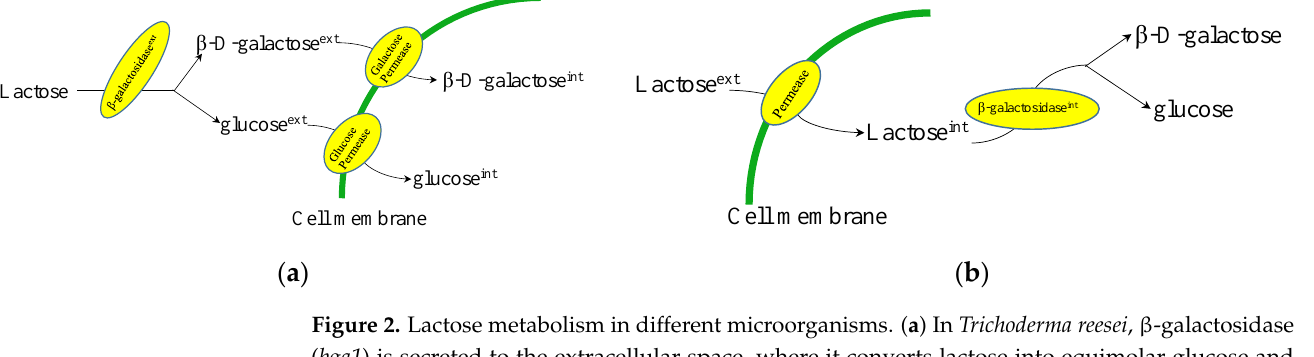
Figure 2. Lactose metabolism in different microorganisms. ( a ) In Trichoderma reesei , β-galactosidase ( bga1 ) is secreted to the extracellular space, where it converts lactose into equimolar glucose and galactose monosaccharides, which are then imported into the cytoplasm. ( b ) In Aspergillus nidulans and Kluyveromyces spp., lactose is first transported into the intracellular space by lactose permease ( LAC12 ) where it is catalyzed into galactose and glucose by cytosolic β-galactosidase ( LAC4 ). T. reesei uses the former pathway for lactose uptake, although the extracellular β -galactosidase (encoded by bga1 gene) is a critical factor for lactose-induced cellulase production [62,63]. A. nidulans and K. lactis , a model microorganism of Kluyveromyces yeast, both utilize lactose through the latter strategy by lactose permease (encoded by LAC12 gene)-mediated transport of the disaccharide into the intracellular compartment and subsequent hydrolysis by β -galactosidase (encoded by the LAC4 gene) into glucose and β - D -galactose. This review does not discuss the catabolism of D -glucose in detail since several current reviews already address this topic. In most eukaryotes, α - D -galactose is converted by aldose 1-epimerase to the α -anomer before entering the Leloir path- way (Figure 3) [64,65], although filamentous fungi contain a second pathway, the oxido- reductive catabolic pathway, for α - D -galactose catabolism [55,66]. However, some strains of K. marxianus have been found to hydrolyze lactose outside of the cell (Figure 2a) [67,68].